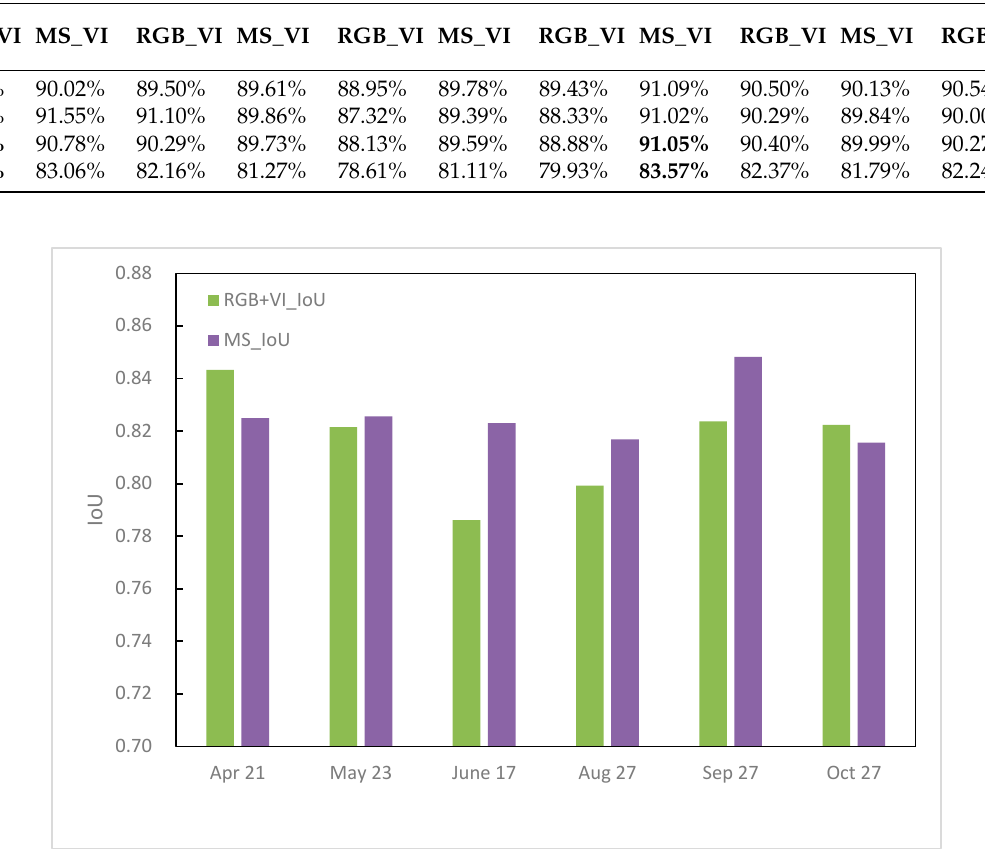
Figure 10. Comparison of the IoU of the RGB model with added VIs and MS imagery without added VIs for di ff erent months.